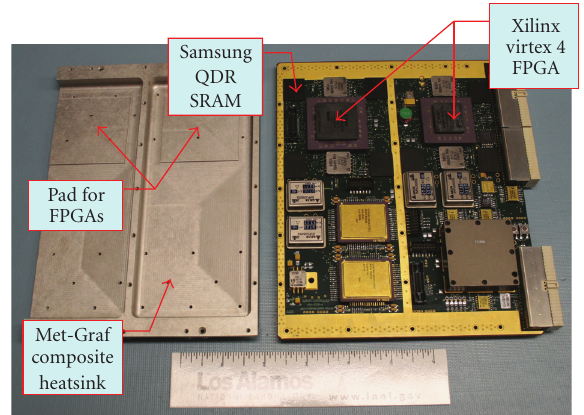
Figure 5: Real-Time Signal Processor (RTSP) board with Xilinx Virtex 4 LX200 and SX55, seven banks of Quad Data-Rate (QDR) memory, and radiation-hardened scrubbing and interface circuitry.